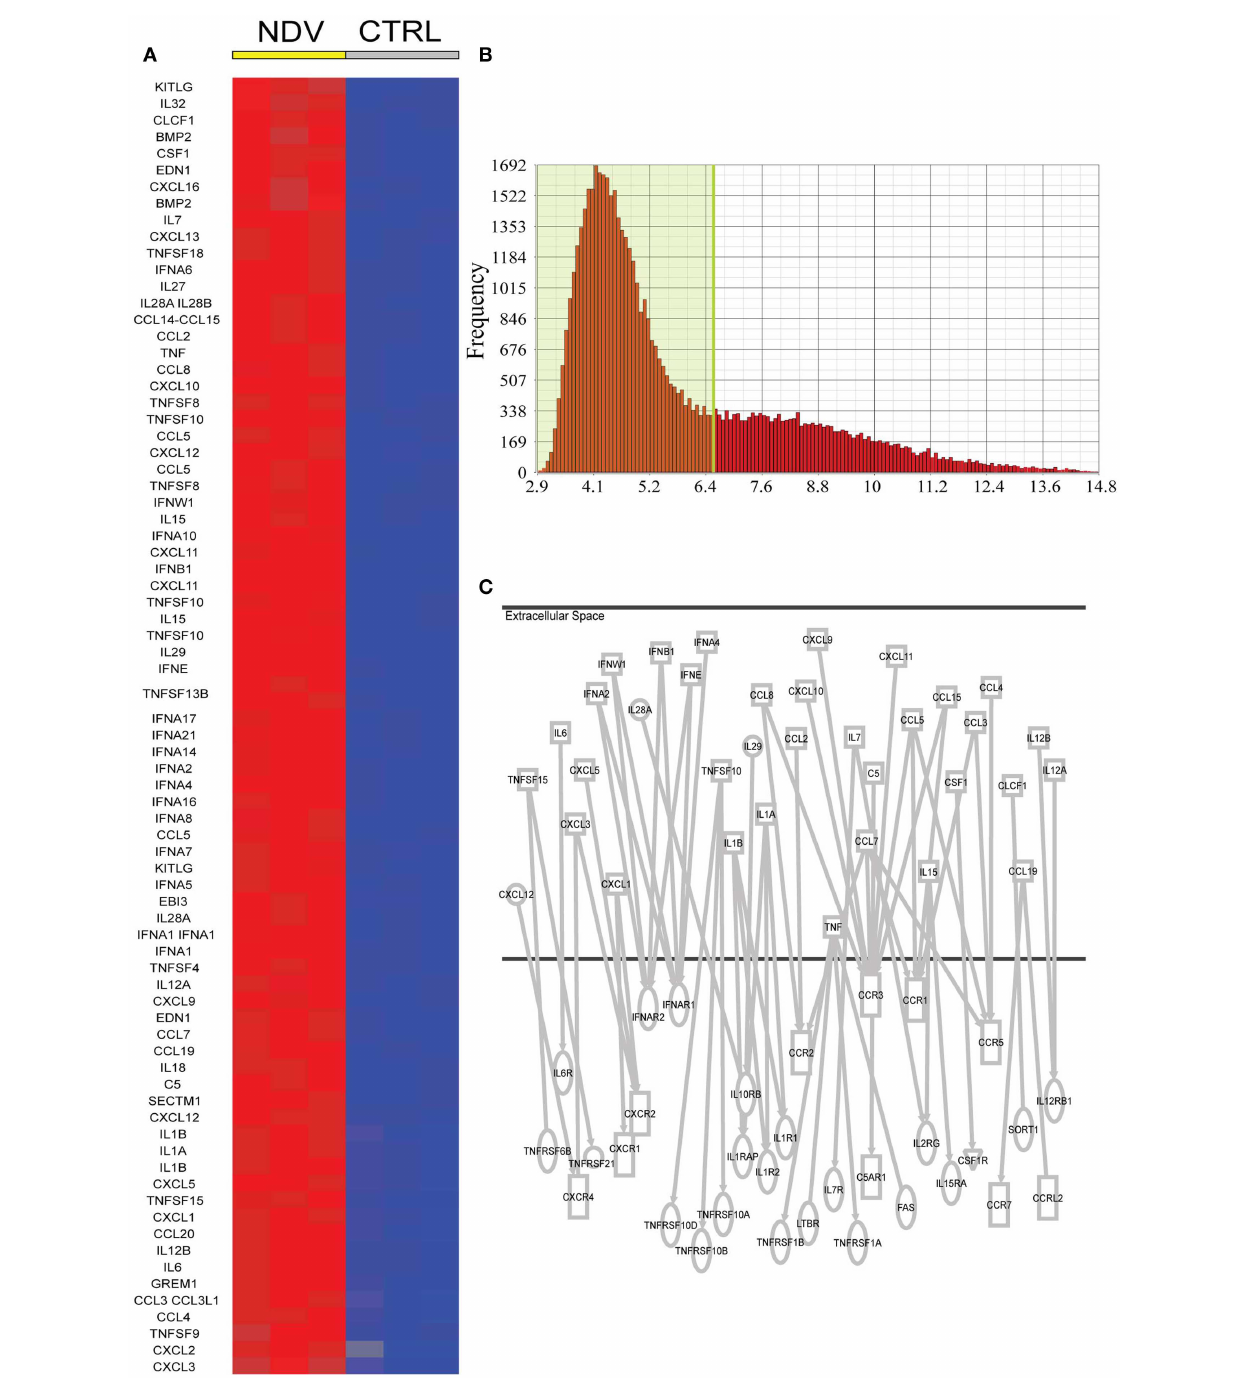
FIGURE 2 | Candidate NDV induced cytokines in DCs for a paracrine effect on DCs . (A) Cytokines and chemokines induced by NDV (twofold FDR p < 0.05) compared to naive DCs. (B) Expression level of all genes expressed